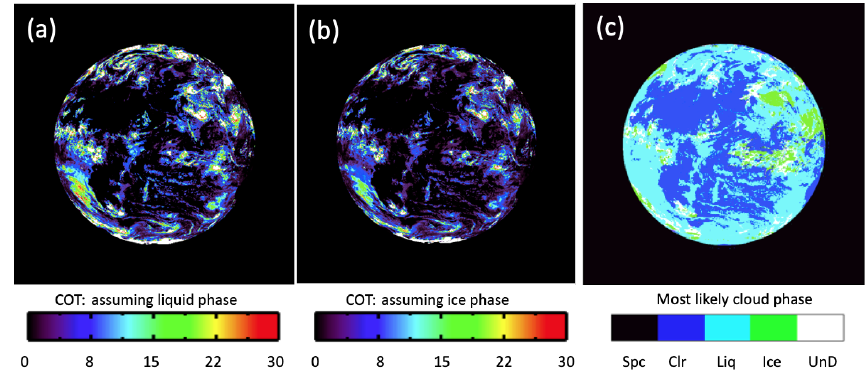
Figure 5. Sample EPIC L2 cloud optical thickness (CODT) products. Same granule as Fig. 3, but for (a) COT retrieval assuming liquid thermodynamic phase, (b) COT retrieval assuming ice thermodynamic phase, and (c) the most likely cloud phase based on cloud effective temperature derived from the A-band CEP.